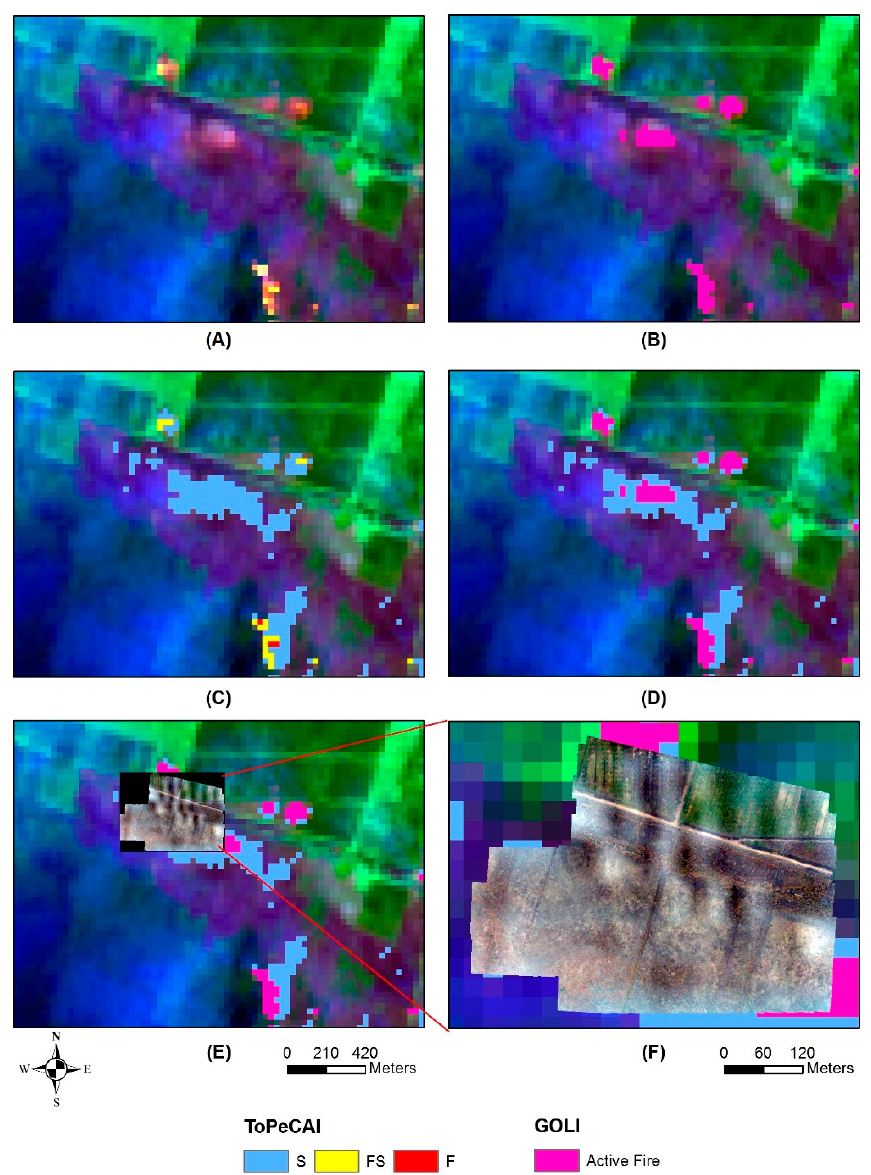
Figure 7. Comparison of Global Operational Land Imager (GOLI) and ToPeCAl implementation on peatland combustion using Landsat-8 28 September 2018, in Central Kalimantan. ( A ) The 764 RGB images of Landsat-8 of peatland combustion area, ( B ) The GOLI active fire (magenta) overlaid on the RGB image, ( C ) The ToPeCAl mapping result on RGB image is shown in three classes of peatland combustion (S, FS, F), ( D ). An overlay of GOLI and ToPeCAl showing a larger area of combustion from ToPeCAL, especially for smouldering fire, ( E , F ) Drone image and its enlargement showing smouldering peatland but not active/flaming fire.